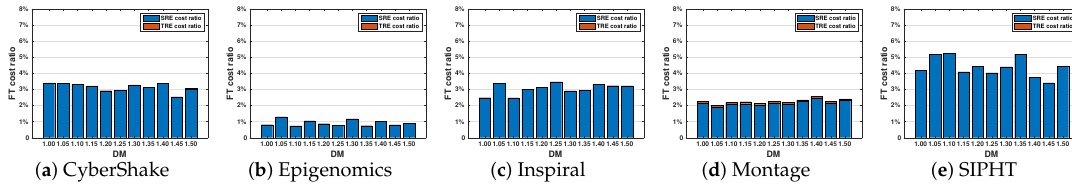
Figure 3. Fault-tolerant (FT) cost ratio of workflows with the increasing deadline multiplier (DM).